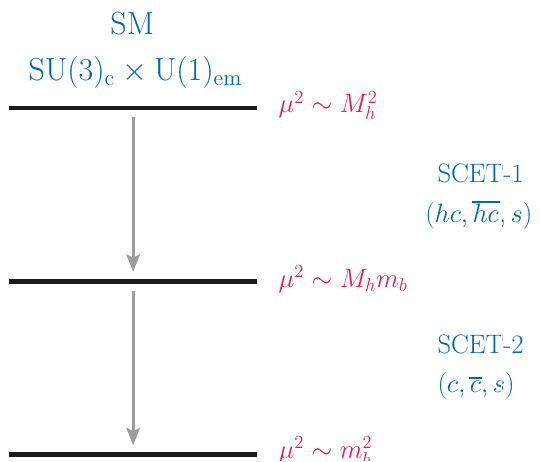
Figure 2 . Schematic illustration of the two-step matching